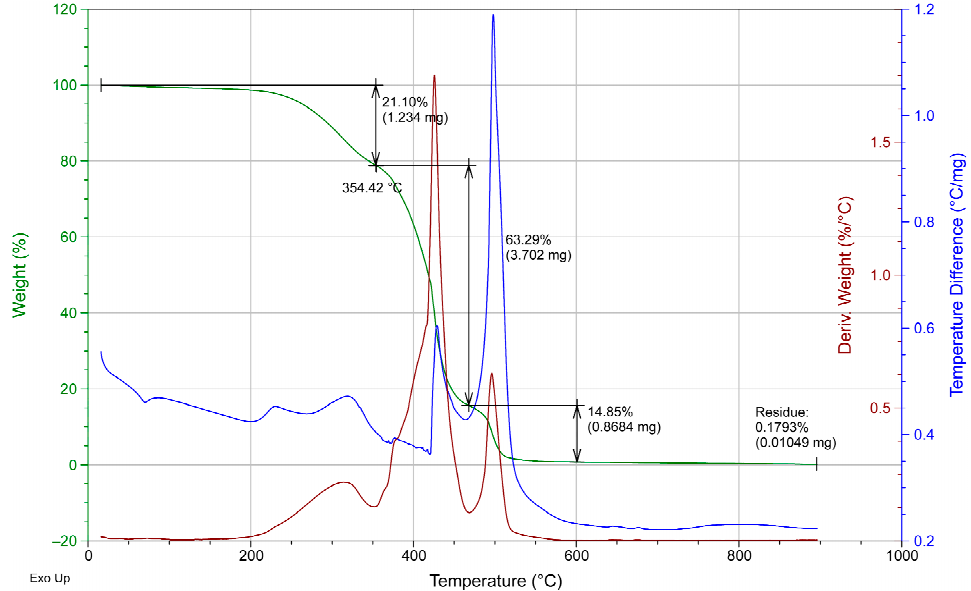
Figure A3. DSC-TGA for the SB-B commercial coating.